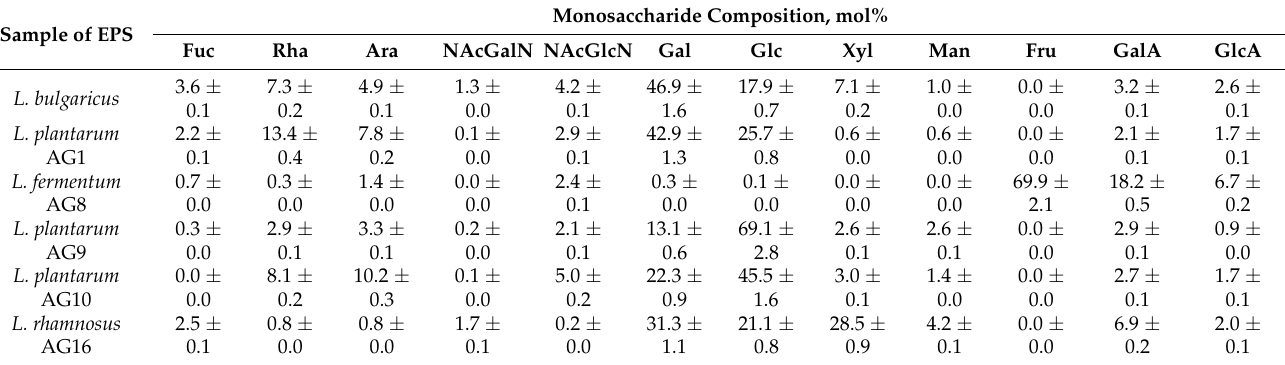
Table 1. Monosaccharide composition of EPS produced by various Lactobacillus species. Monosaccharide Composition, Sample of EPS